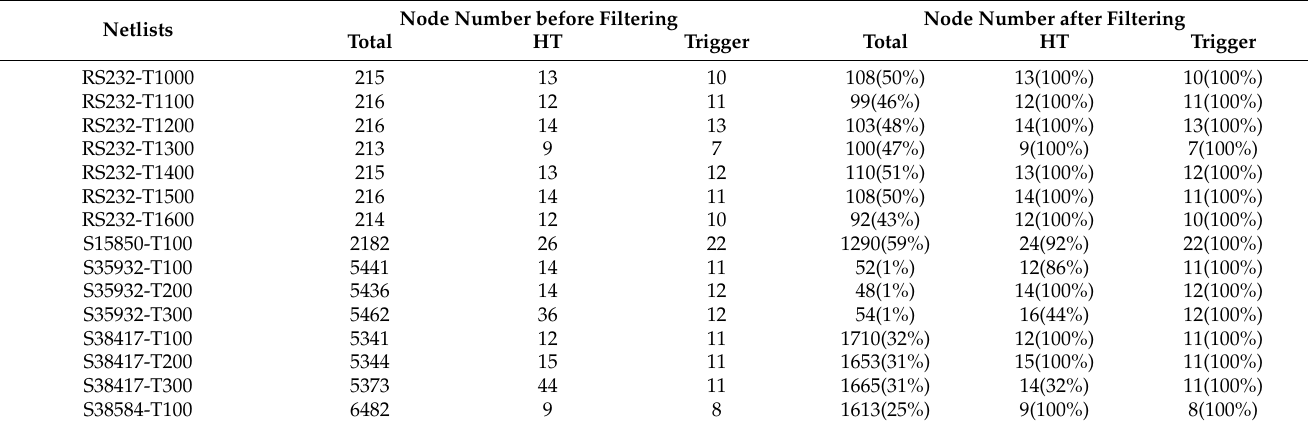
Table 4. Result of node